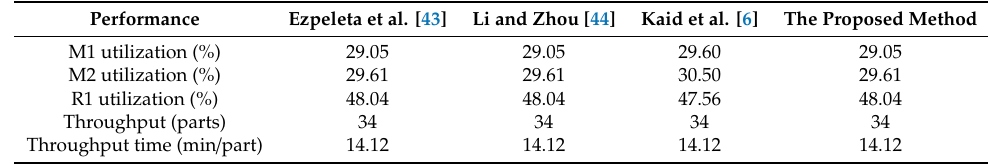
Table 1. Time performance comparison with the existing